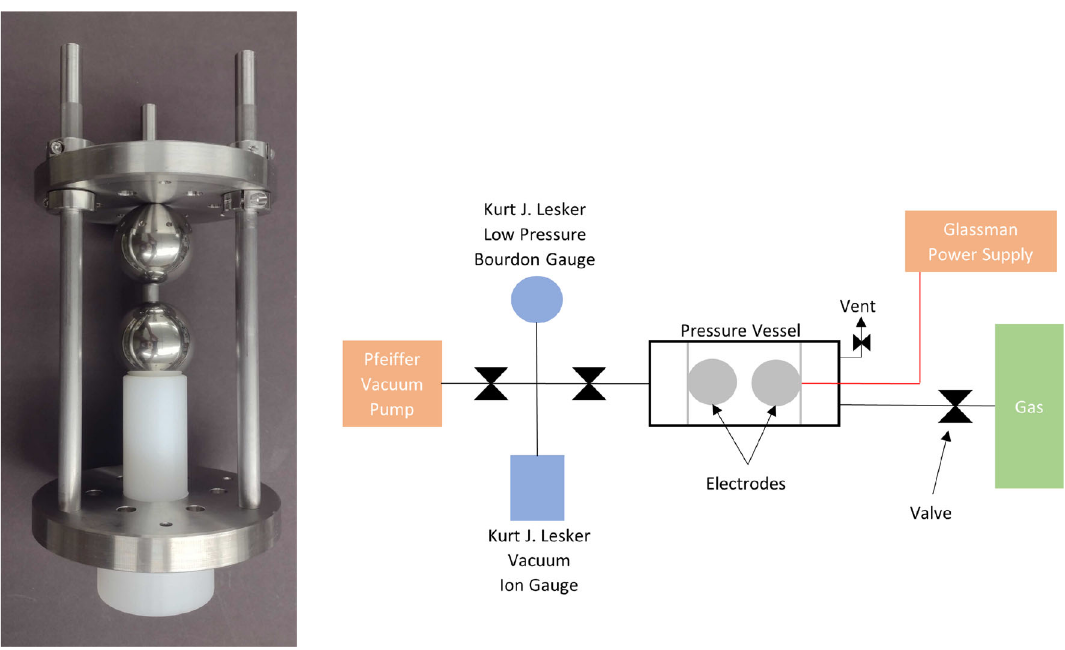
Fig. 2 Left: A photograph of the apparatus used in this study. Breakdowns are initiated between two polished spheres with an adjustable gap width, at voltages of up to 50 kV. Right: Block diagram of the experiment showing key system components